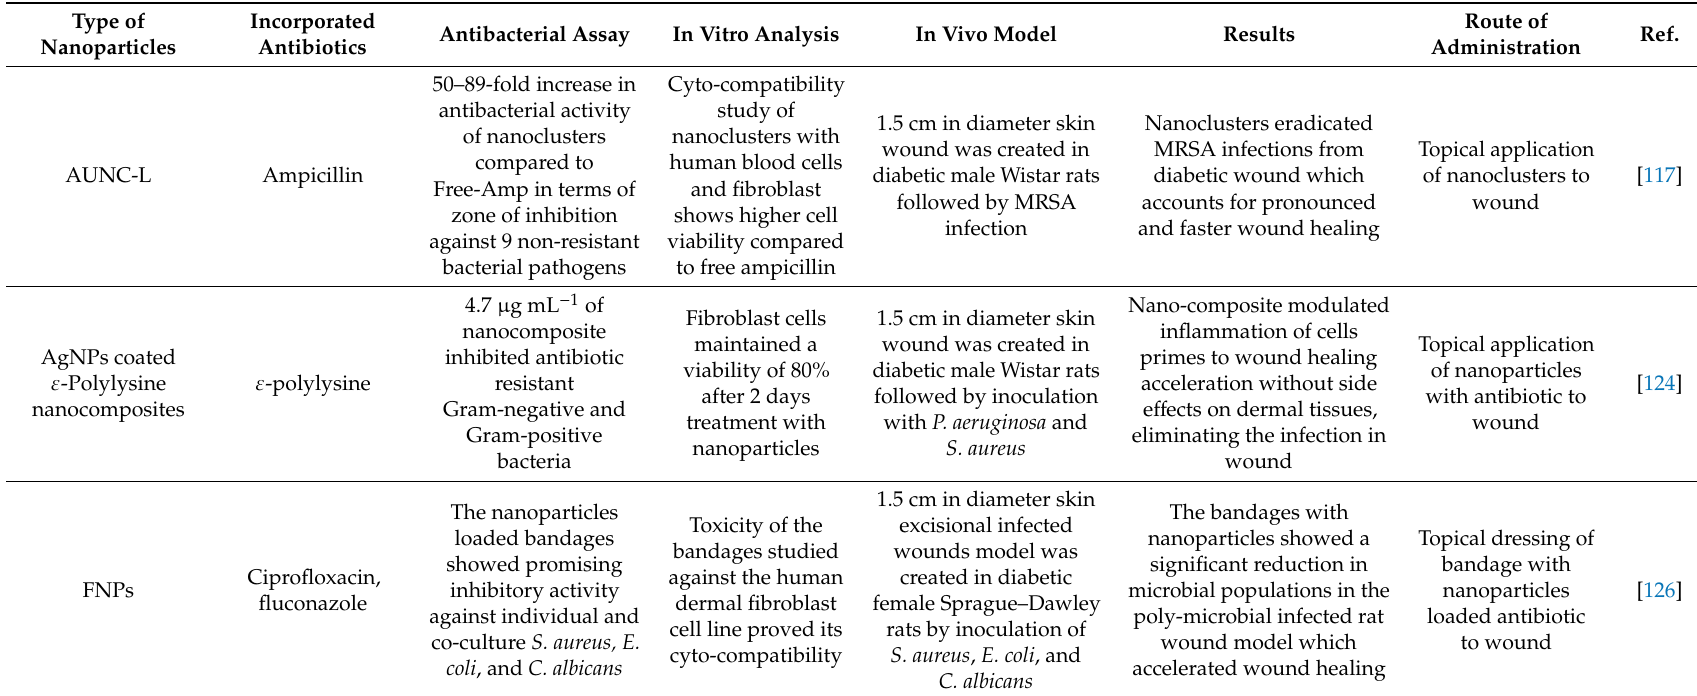
Table 3. Nanoparticles-based therapeutics incorporated with an antibiotic for diabetic wound